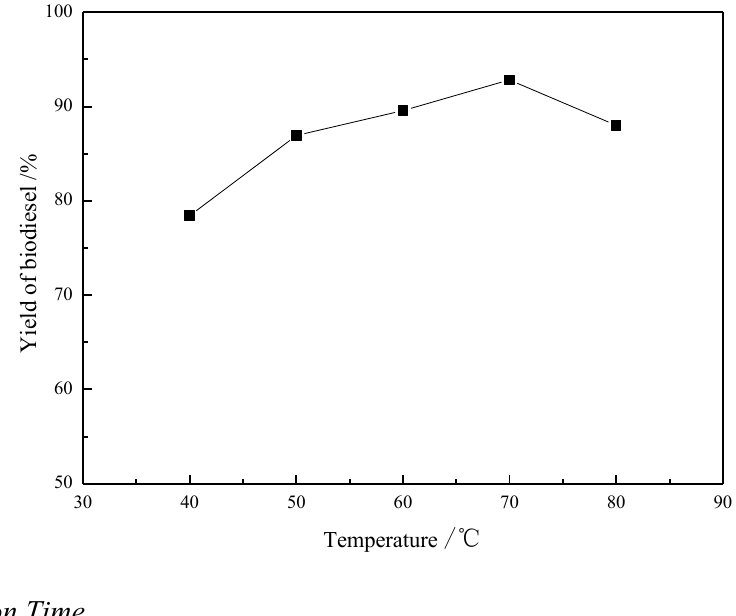
Figure 5. Effect of reaction temperature on the yield (y) in preparation of biodiesel catalyzed